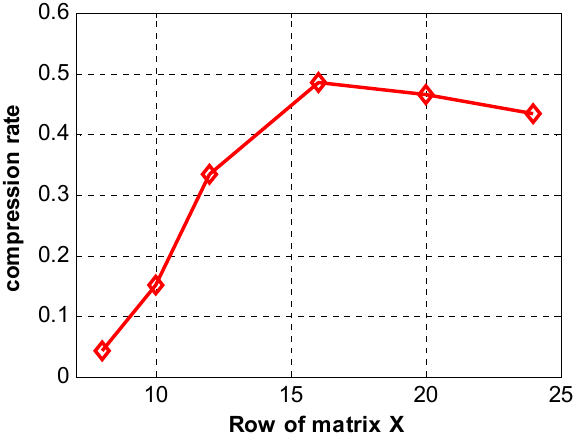
Figure 4. Compression rate for different format of matrix.